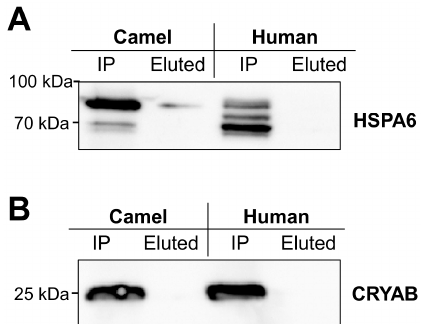
Figure 3. Differential glycosylation of camel and human HSPA6. ( A ) Helix pomatia (lectin)-conjugated Sepharose was used to discriminate between the glycan structures of the Myc-tagged camel and human HSPA6 proteins. The extracted proteins from camel/human HSPA6-transfected COS-1 cells were mixed with Helix pomatia lectin-Sepharose for 2–3 h and the bound proteins were eluted with 10 mM N -acetyl-glucosamine. Camel HSPA6, but not the human species bound to the lectin. As a positive control, immunoprecipitation (IP) of camel and human HSPA6 was performed; ( B ) Similar experiment was performed for the Myc-tagged camel and human CRYAB. In contrast to camel HSPA6, both chaperones did not bind to the lectin. HSPA6 and CRYAB were detected by anti-Myc antibody. The Western blot shown is representative of three experimental independent repeats.